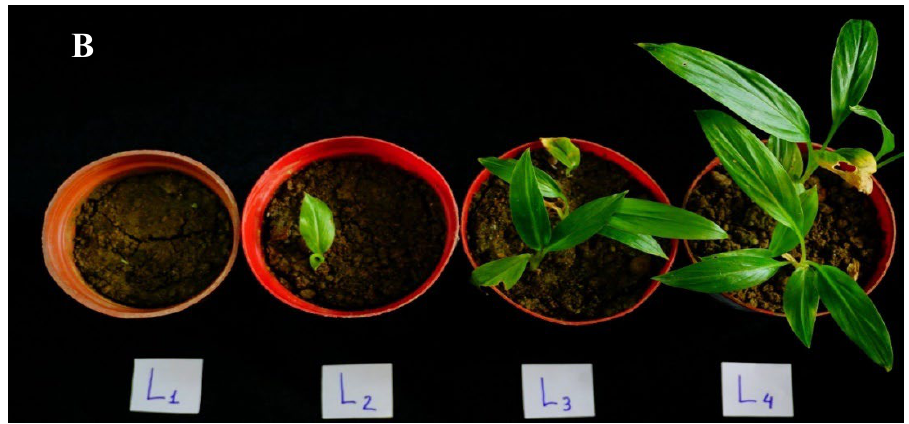
Figure 5. Germination and growth characteristics of different microrhizome sizes (L1, L2, L3, L4) sown in plastic pots after two months of ex vitro culture. A: front view, B: top view. Scale bar: 10